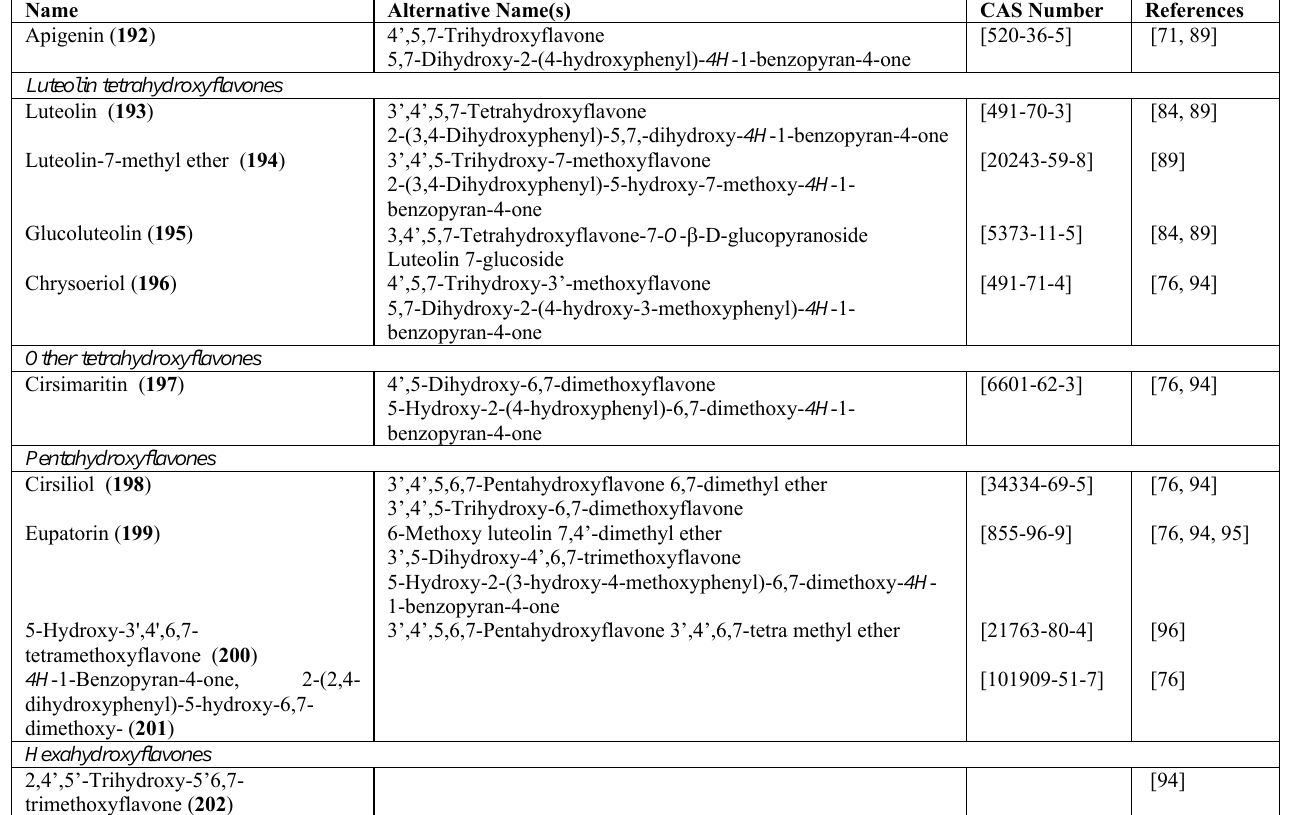
Table 18. Flavones (2-Phenyl- 4H